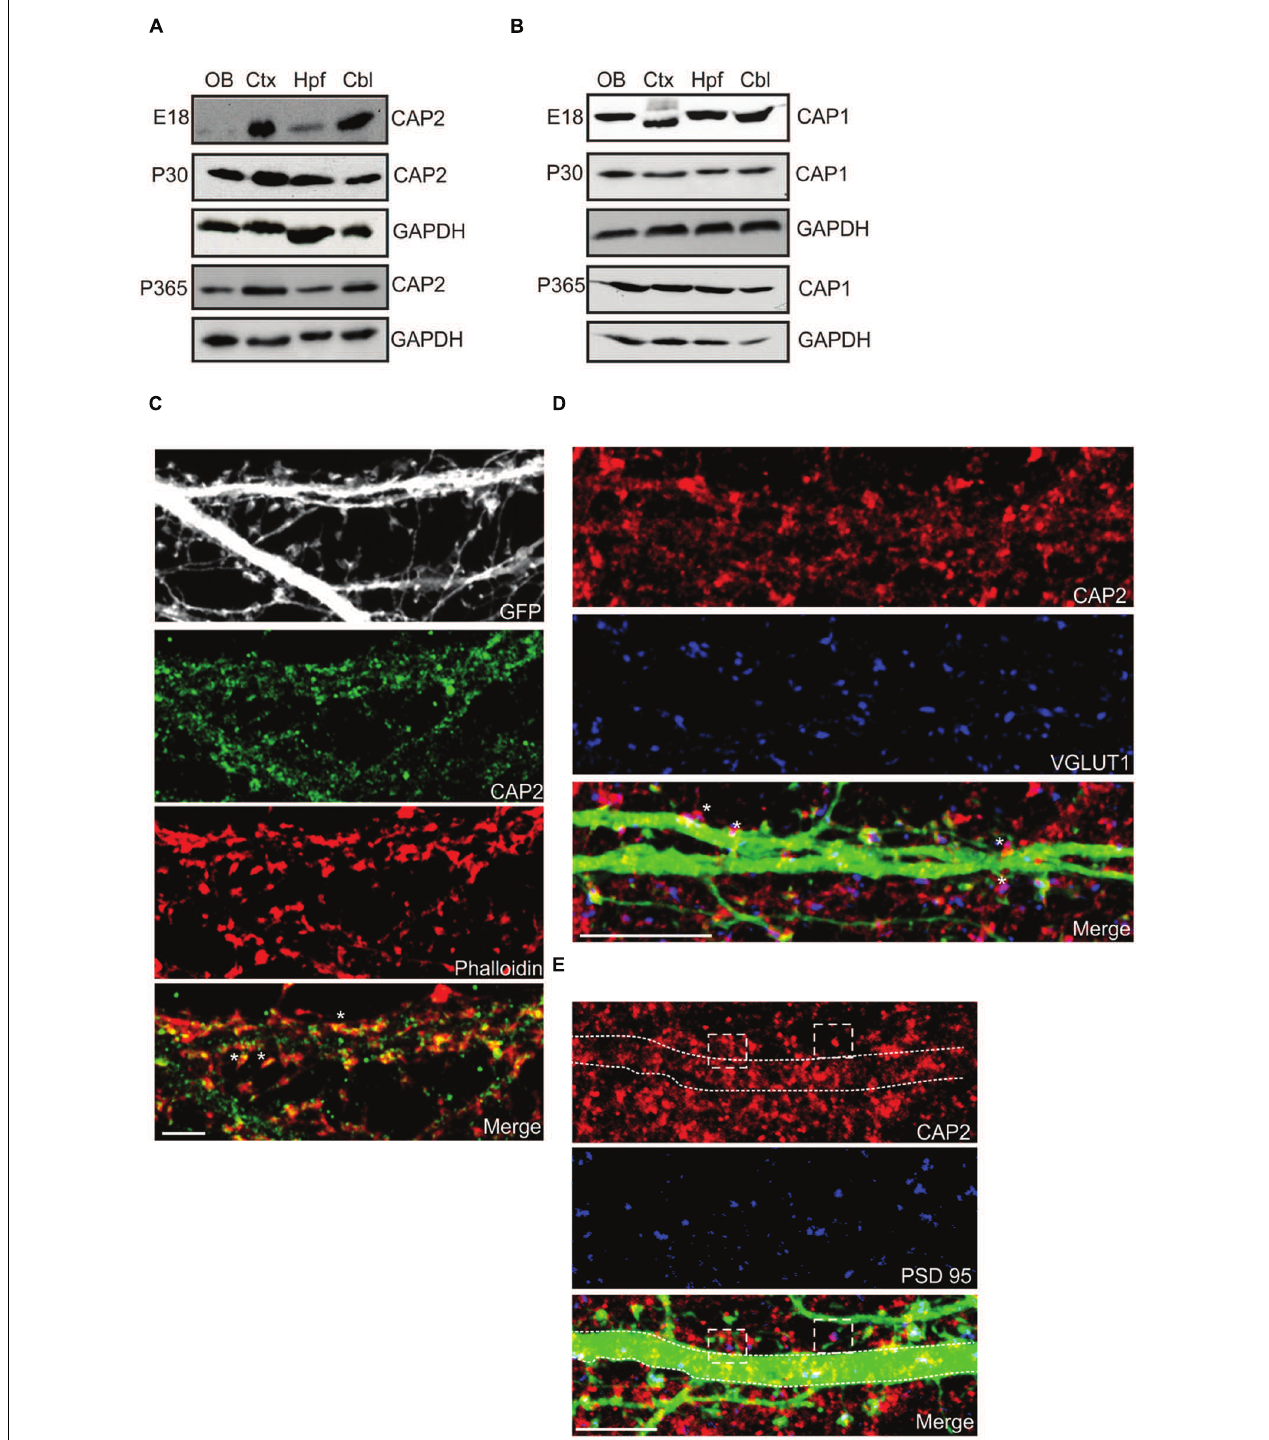
FIGURE 1 | Expression and localization of CAP2 in brain. (A) Western blot analysis of CAP2 in lysates from dissected brain regions at different developmental stage. (B) Western blot analysis of CAP1 in lysates from dissected brain regions at different developmental stage. (C) Immunocytochemistry of cultured cortical pyramidal neurons demonstrates the presence of CAP2 (green) in the dendritic shaft and mature spine. F-actin rich structures were visualized with TRITC-phalloidin (red). Scale bar, 10 µ m. (D) Co-labeling with antibodies against VGLUT1 (blue) revealed the presence of CAP2 in excitatory presynaptic terminal of pEGFP-C2 labeled neurons (merge, white asteriks). However, homogeneous distribution was observed in the axonal shaft. Scale bar, 10 µ m. (E) Co-labeling of cultured cortical neurons with antibodies against CAP2 (red) and PSD-95 (blue) revealed that CAP2 localizes with PSD-95 (white dashed square). Scale bar, 5 µ m.